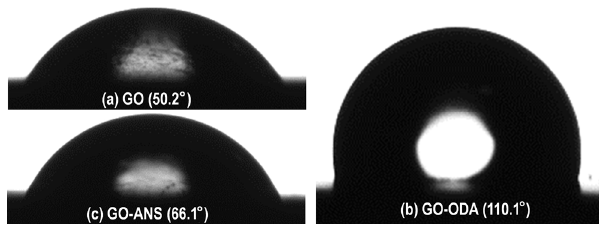
Fig. 3 Water contact angle measurements on (a) GO, (b) GO-ODA, and (c) GO-ANS pallet.